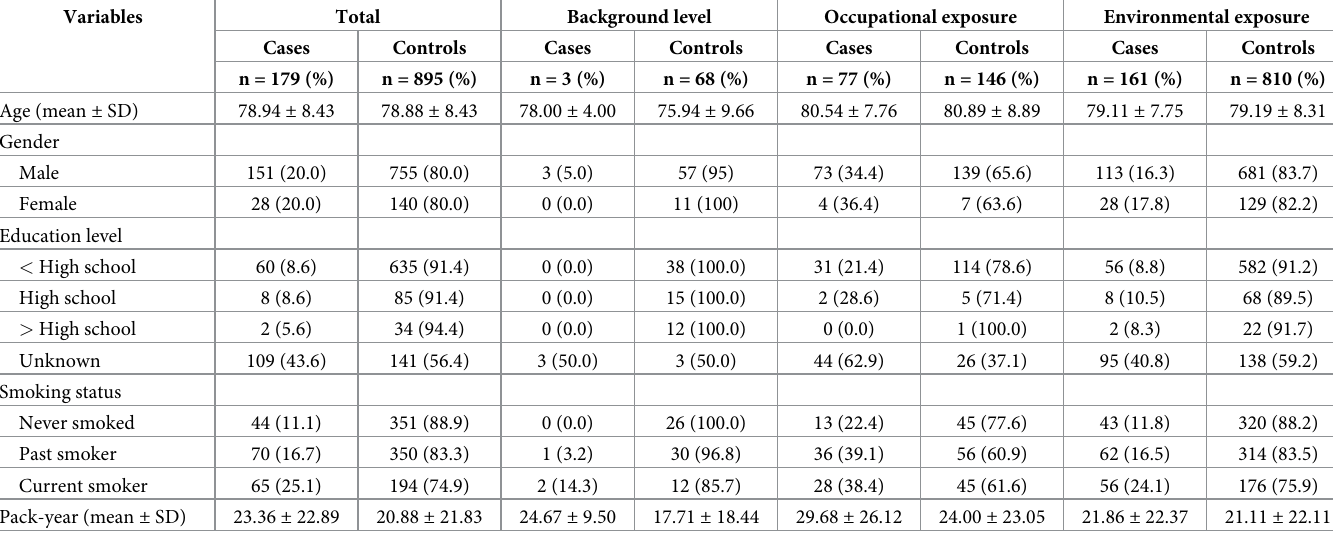
Table 2. Descriptive statistics of total cases and controls participating in the study (191 participants are co-exposed to occupational and environmental